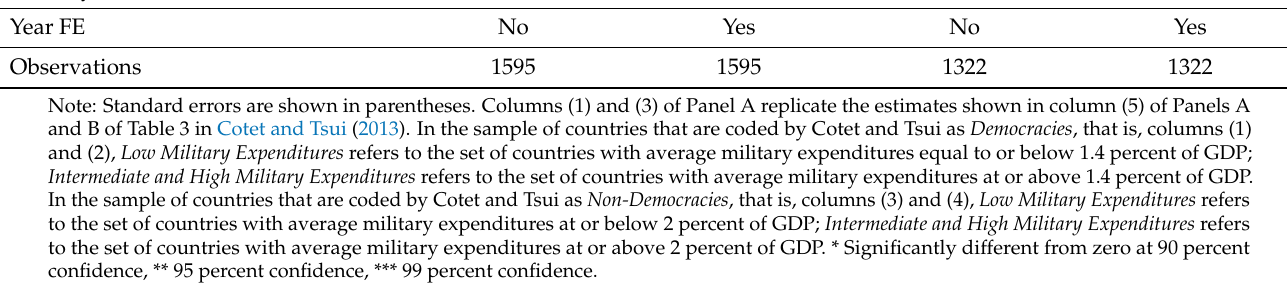
Table A7. Cotet and Tsui (2013, AEJ Macro) “Oil and Conflict”. Fixed Effects 2SLS Regressions.